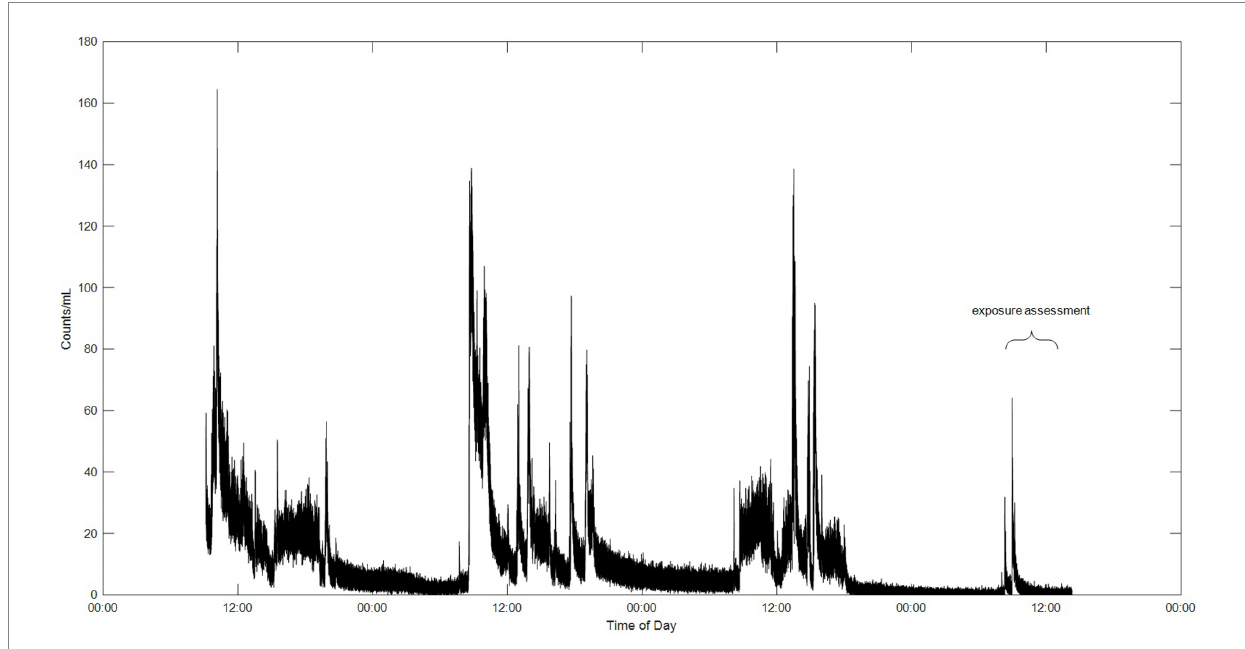
FIGURE 1 Data from a particle sensor placed at a workspace, in the same facility as the extrusion process, for four workdays showing the fluctuations of emissions during the